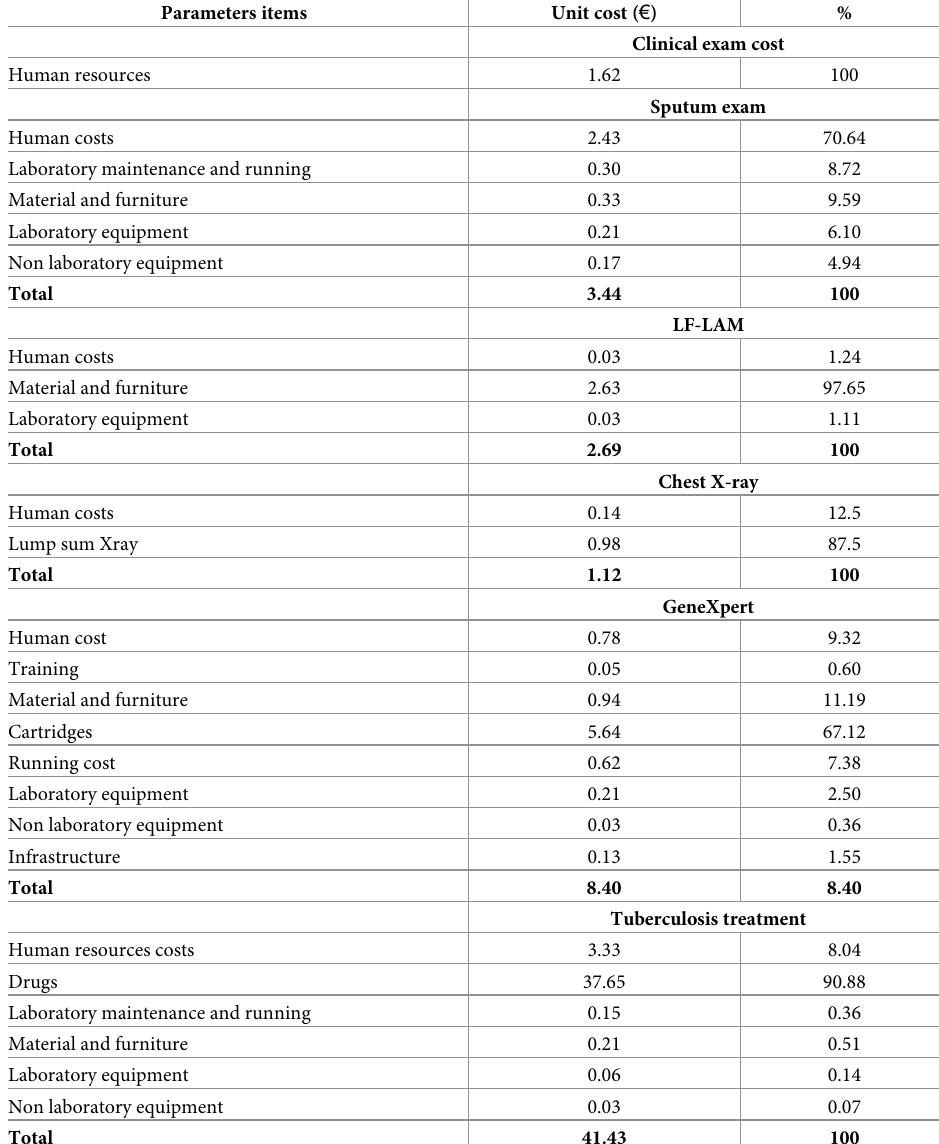
Table 2. Costing details, in Euros (4%